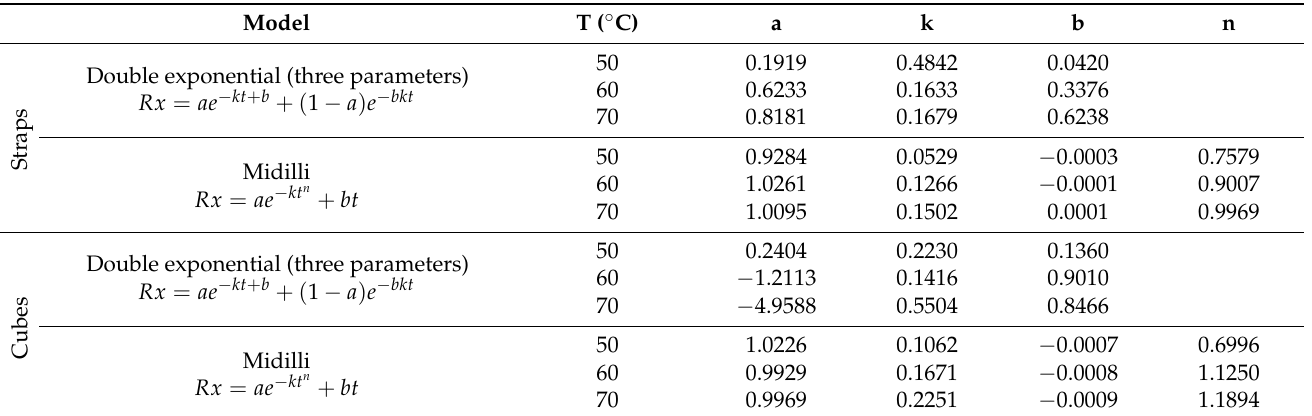
Table 6. Coefficients of the double exponential with three parameters and Midilli models that describe the drying curves of prickly-pear cladodes cut into different geometries and exposed to different